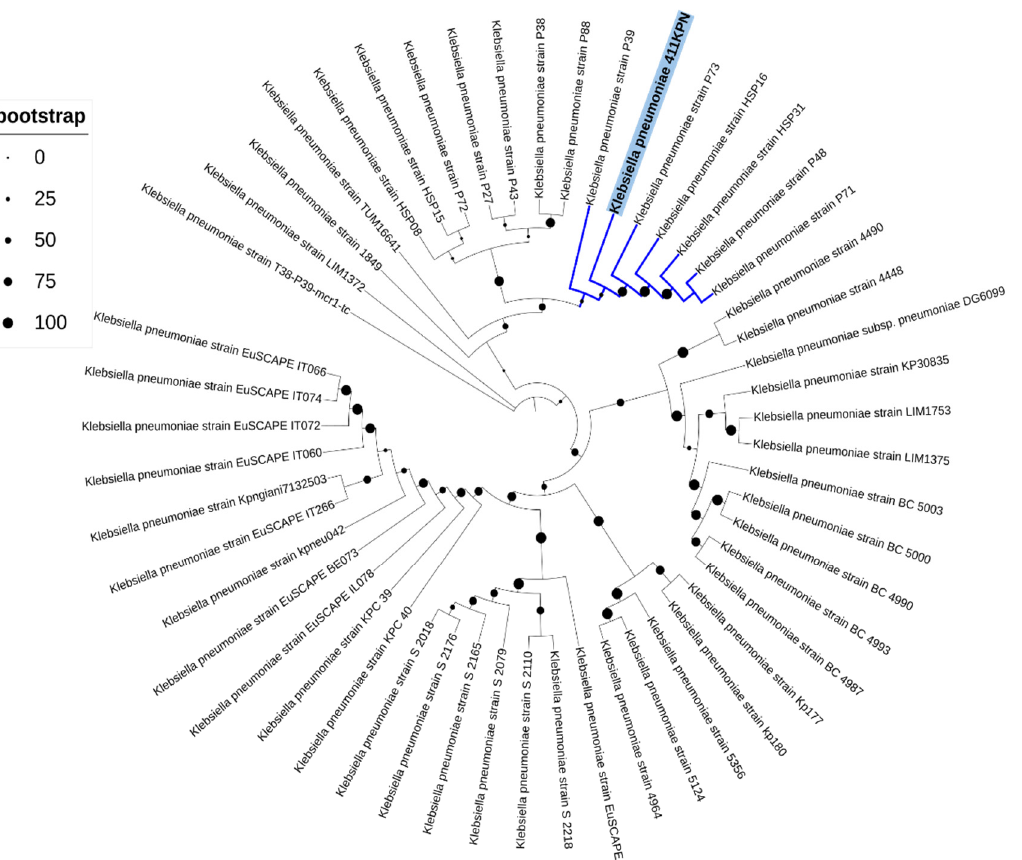
Figure 1. Phylogenetic tree of KP411 strain and 52 K. pneumoniae genomes deposited at GenBank ® . The phylogenetic tree was built using the algorithm based on maximum likelihood (RAxML) on the PATRIC platform and edited on the iTOL v6 program. The KPN411 strain was highlighted, and the internal node is indicated in bold.